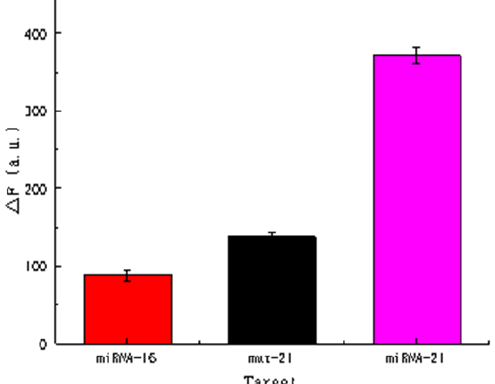
Figure 10. Selective detection of miRNA using the sensing system. The concentration of miRNA-16 and mut-miRNA was 5 nmol L − 1 , while the concentration of miRNA-21 was 5 pmol L − 1 .